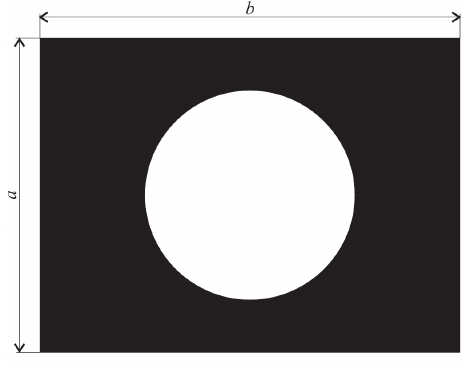
Fig. 7. A model of the round mark